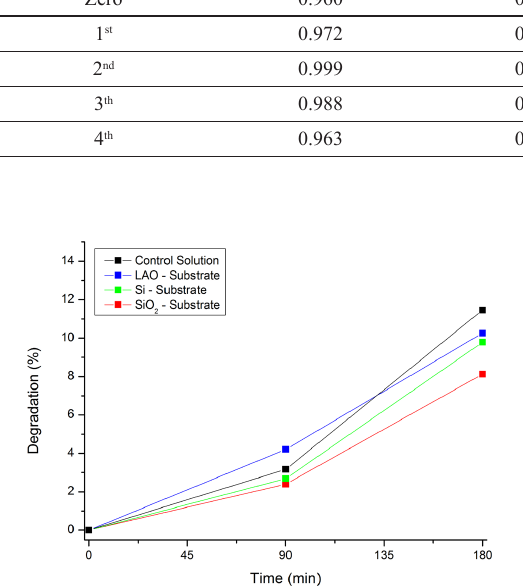
Figure 4. Degradation of methylene blue by the bare substrates only. The reactors containing LAO, Si, and SiO irradiated by UV lamps for 0, 90, and 180 minutes test for control solution, The square dots represent the results of the measurements. The thin solid lines are just a guide to the eyes.